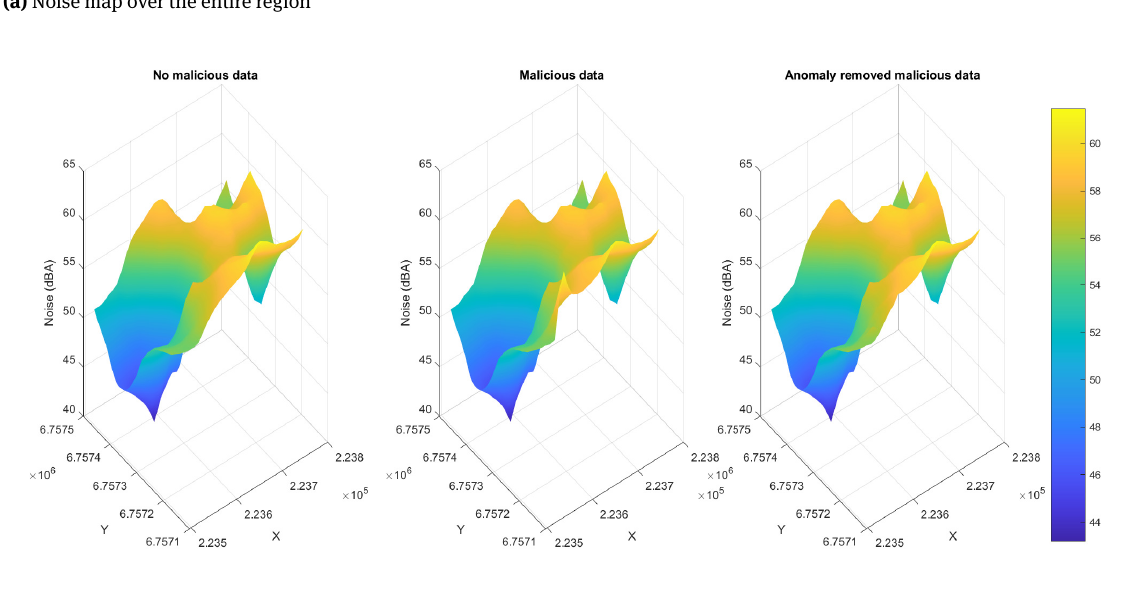
ample, we use a basic “datapoints farther than s